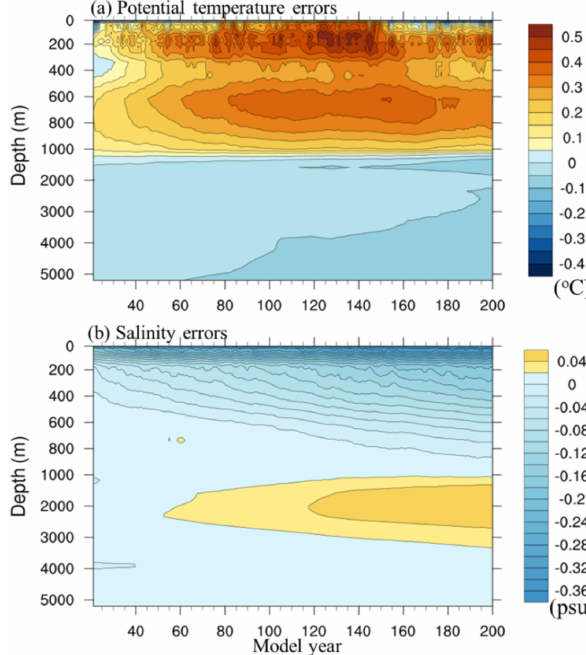
Figure 14. Time series of global averaged errors of ocean (a) tem- perature and (b) salinity simulated by the CPE-parallelized CESM- HR on the Sunway machine against the climatological